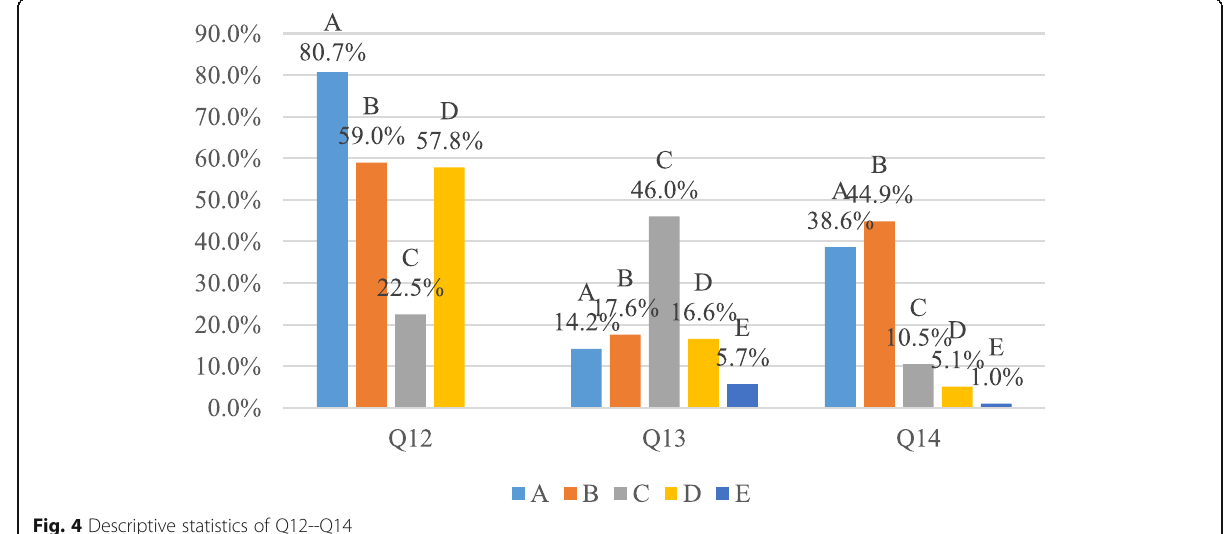
Fig. 4 Descriptive statistics of